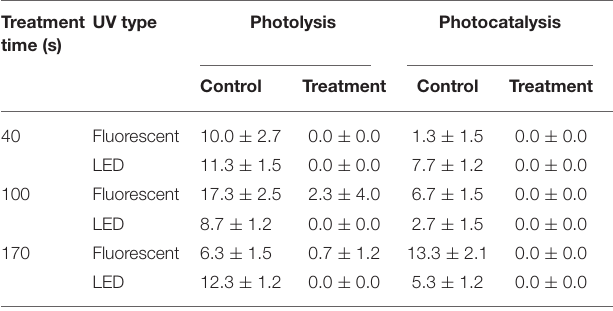
Values in table report average concentration ± standard deviation. All figures are statistically significant.